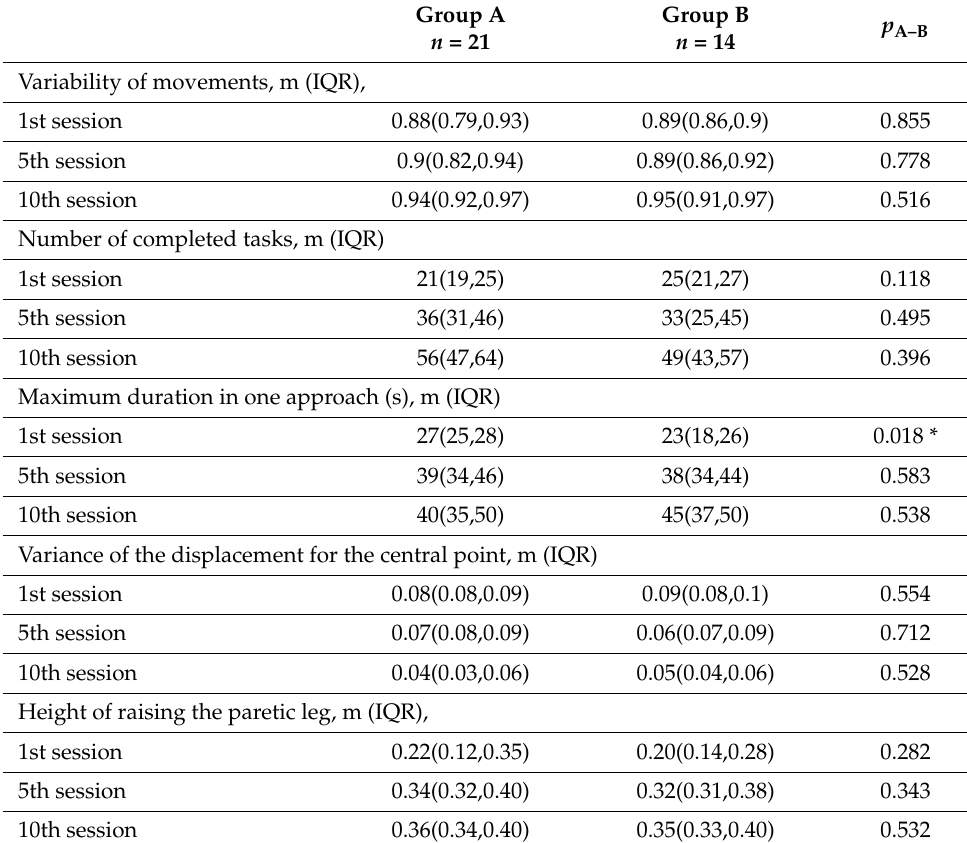
Table 4. Estimated mean differences in parameters of movement quality during AR rehabilitation between A and B groups.